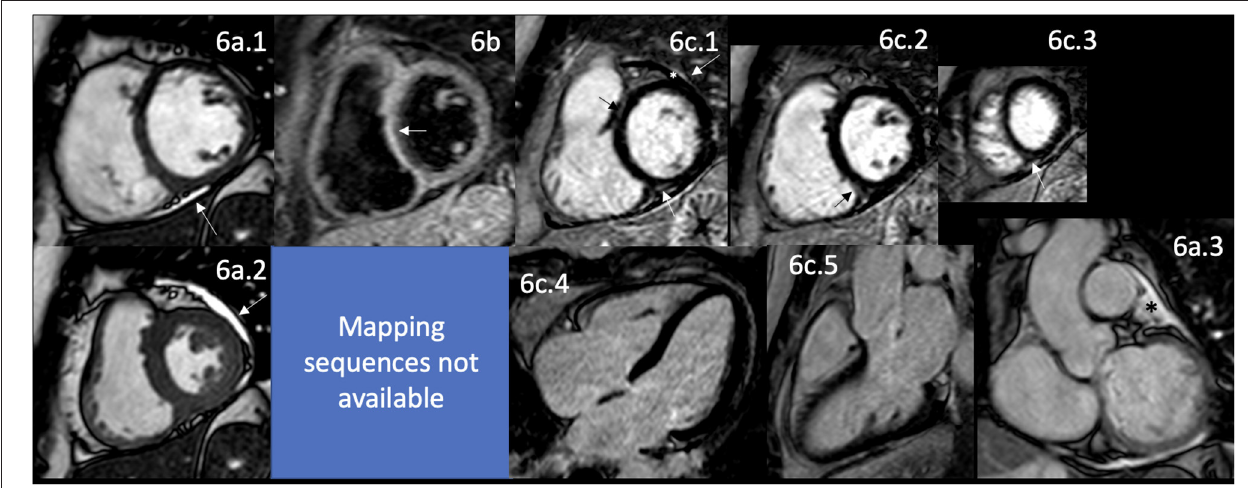
FIGURE 6 | CMR findings in DS. A panel figure demonstrates varying findings from a comprehensive CMR study at a 1.5 Tesla scanner of DS. (a) SSFP sequence still cine images in short-axis view at the mid-ventricular level in end-diastole (a.1) and end-systole (a.2) show normal global and regional functions of the left ventricle, LVEF 63% and mildly reduce systolic global RV function and mild global hypokinesia RVEF 45%. (a.3) In a coronal view showing the mild pericardial effusion surrounding the heart (asterisks). (b) T2-W STIR sequence in short-axis view at a mid-ventricular level showing increased signal intensity in the septal segments (arrow) with a myocardial/skeletal muscle ratio of 2.3, suggesting mild myocardial edema. (c.1–5) LGE PSIR sequence. (c.1–3) Short axis views at basal (c.1) , mid (c.2) , and apical (c.3) levels, and long-axis views in four-chambers ( c.4 ) and three-chambers ( c.5 ). The arrows in these images show areas of focal fibrosis as midventricular LGE of the anteroseptal and inferior segments in (c.1) and in the subepicardium of the inferior segment in (c.2,3). (c.1) Shows mild pericardial effusion (asterisks) and trivial pericardial enhancement (arrow), suggesting minimal pericardial inflammation. CMR, cardiovascular magnetic resonance; DS, DRESS syndrome; SSFP, steady-state free precession; LVEF%, left ventricular ejection fraction; RVEF%, right ventricular ejection fraction; T2-W STIR, T2-weighted short-tau inversion recovery; LGE, late gadolinium enhancement; PSIR, phase-sensitive inversion recovery.